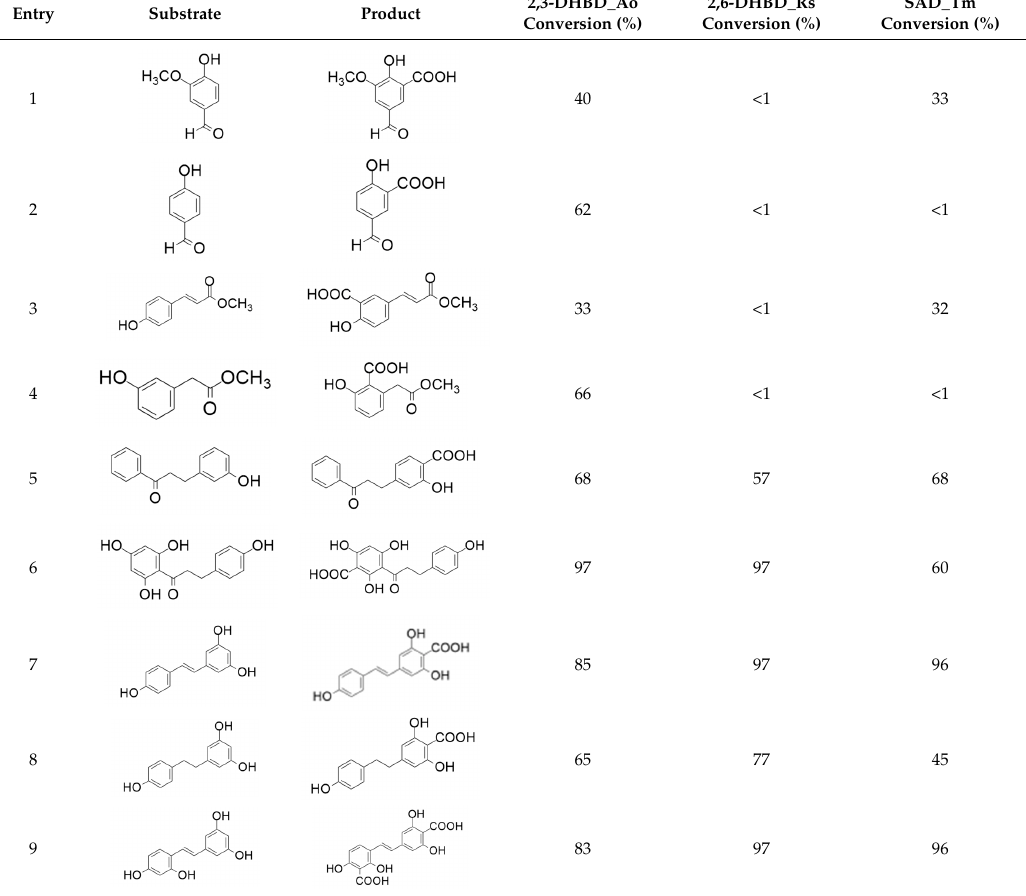
Table 4. Carboxylation of phenols and polyphenols by 2,3-DHBD_Ao, 2,6-DHBD_Rs and SAD_Tm enzymes. Adapted with permission from [61]. Copyright 2017, John Wiley and Sons.